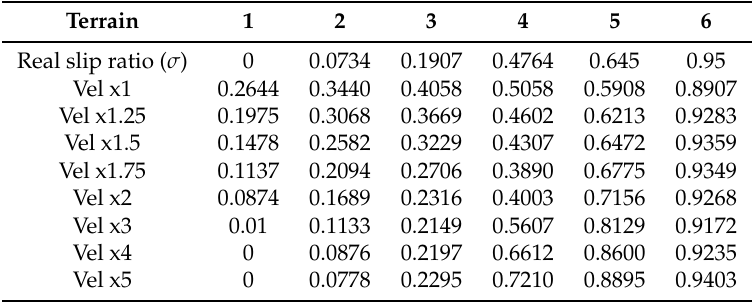
Table 5. Obtained slip ratios for the different terrains and wheel velocities.